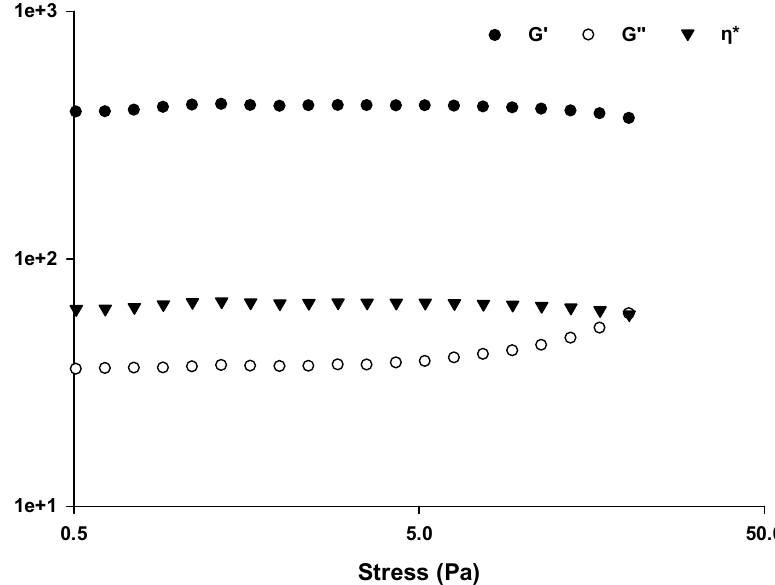
Figure 2. Stress sweep curves for G’ (Pa), G” (Pa) and η * (Pa · s) as a function of stress at a constant frequency of 1 Hz, obtained for the medium HEC100, representative of the profiles observed in the tested samples from all media. G’: storage (elastic) modulus; G’’: loss (viscous) modulus; HEC: hydroxyethyl cellulose; η *: viscosity; 100: 100 mg L − 1 .